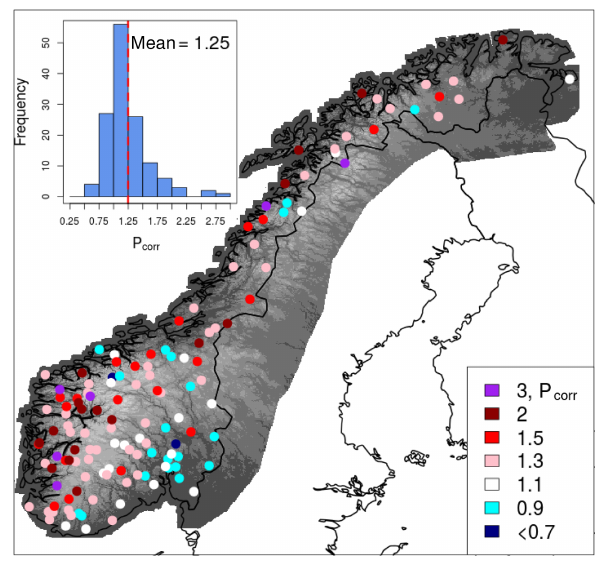
Figure 8. Geographical distribution of P corr . The inset shows the histograms with the distribution of P corr values; the mean value is